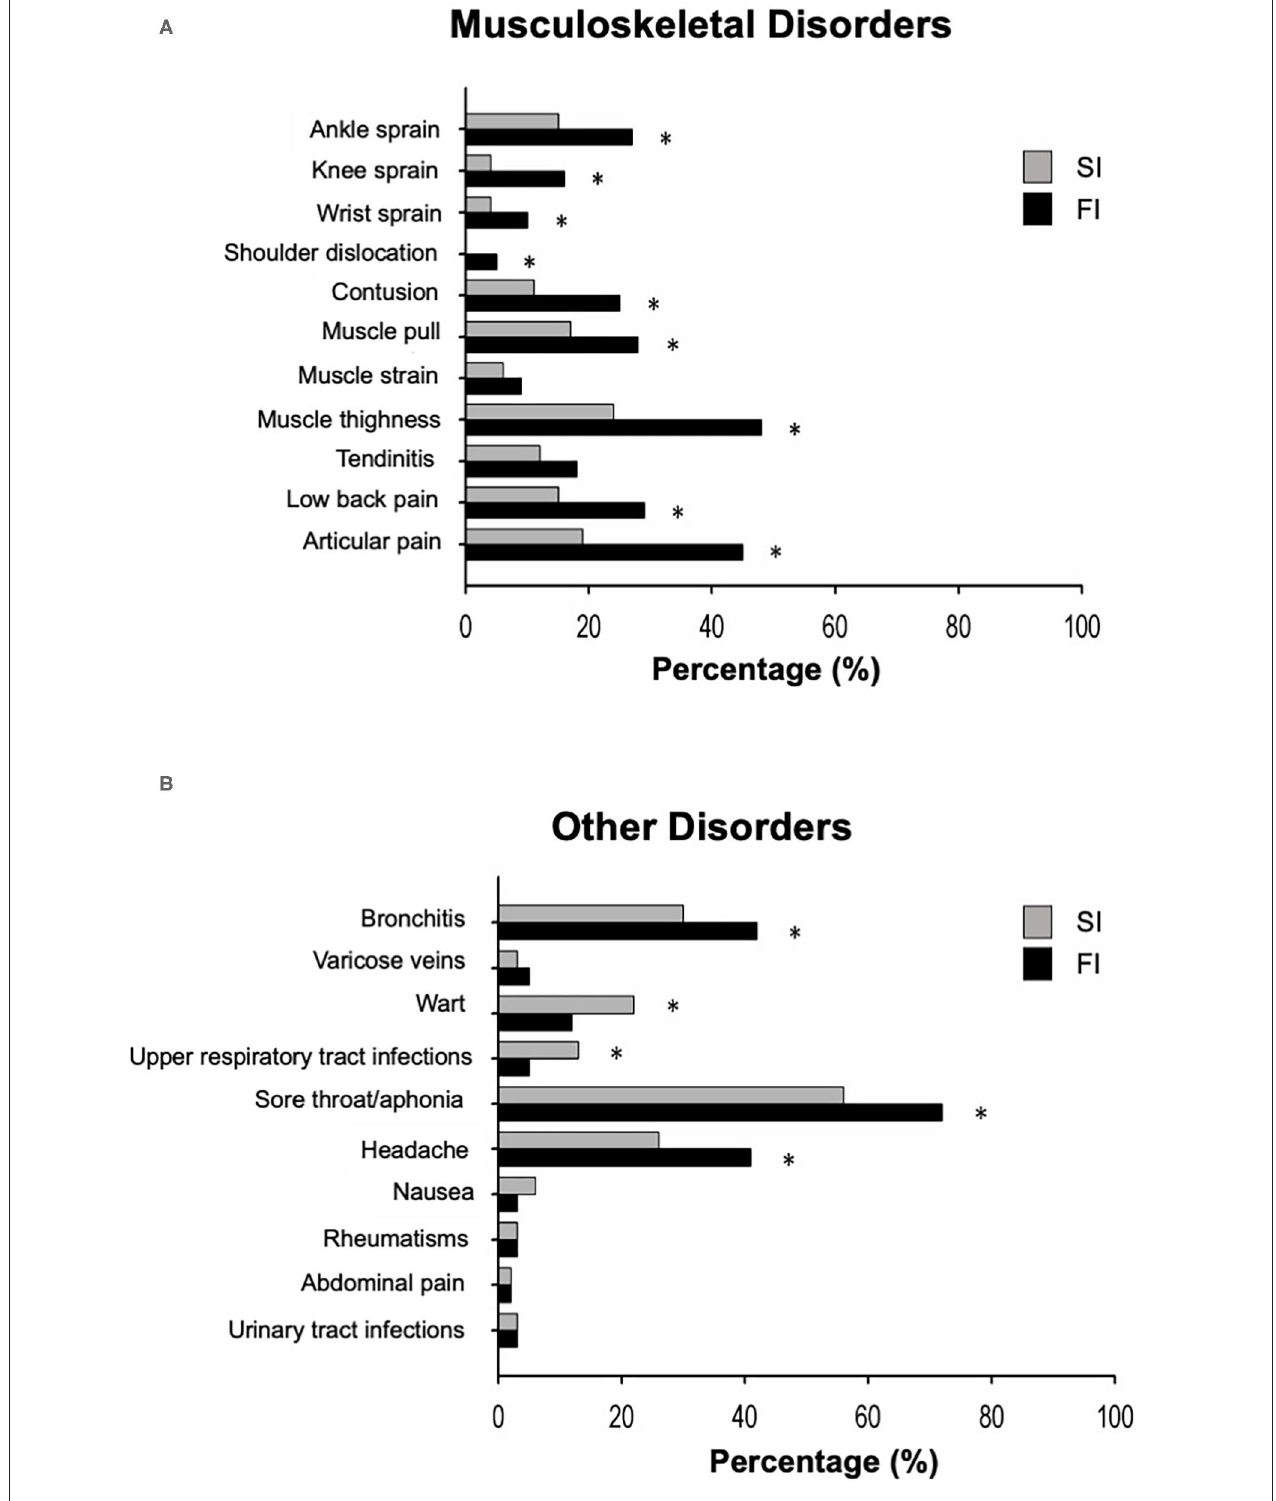
FIGURE 2 | The figure represents the proportion of individuals in the swimming and fitness instructor groups (SI, swimming instructors, n = 179; FI, fitness instructors, n = 256), who experienced specific musculoskeletal injury (A) or other disorders (B) in the last 2 years. * p < 0.05 between groups.